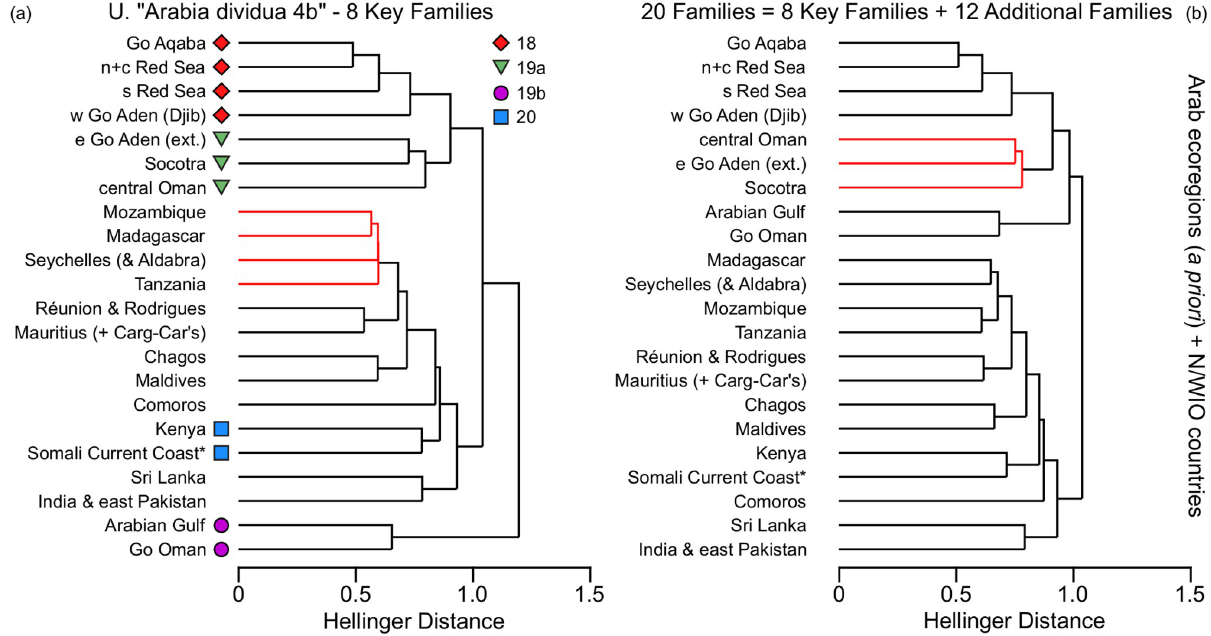
Fig 8. Resemblance pattern of 10 putative Arabian ecoregions, and countries and island groups of the wider Northern, Western and Central Indian Ocean. The dendrogram (a) of the hierarchical agglomerative cluster analysis of 604 species in 8 key families is compared to the dendrogram (b) of the hierarchical agglomerative cluster analysis of 1292 species in 20 core families; with (a) superposed with symbols representing the statistically (ANOSIM) most significant a priori Combination U of province-level designations for Arabian ecoregions (compare Fig 4a) (within-cluster data structure without SIMPROF support indicated in